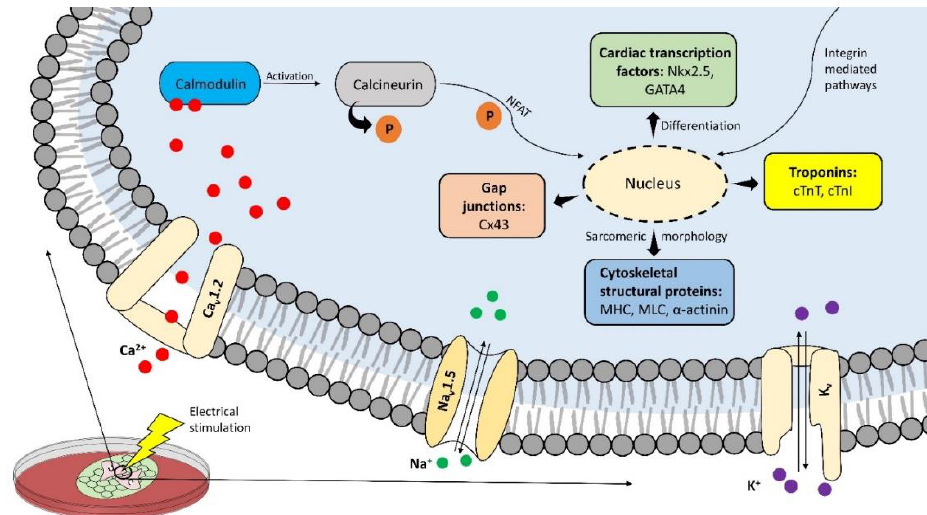
Figure 3. Conductive nano-constructs can trigger intracellular signalling pathways when cultured with stem/precursor cells particularly when stimulated electrically. These pathways then lead to the elevated expression of cardiac-specific genes and transcription factors resulting in the cardiac phenotype of the cultured cells.